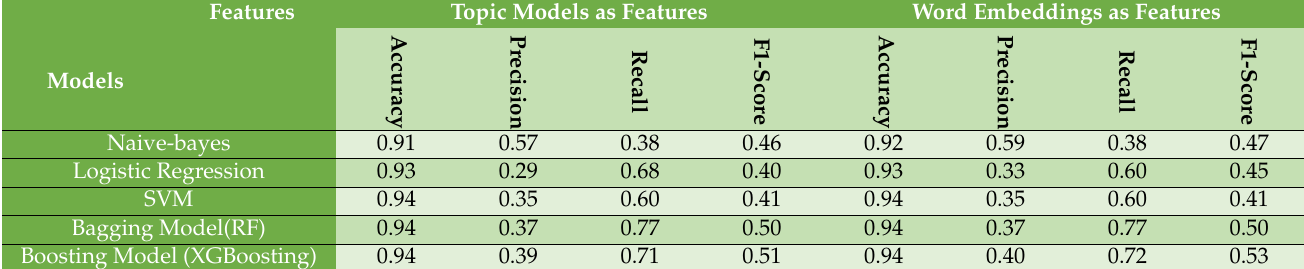
Table 3. Base models 2.